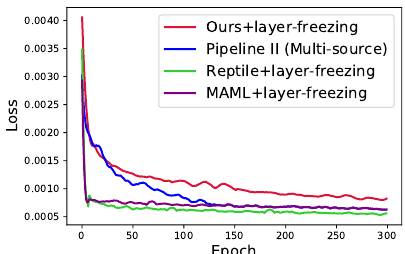
Figure 6. The convergence of three different approaches under the few-shot scenario of